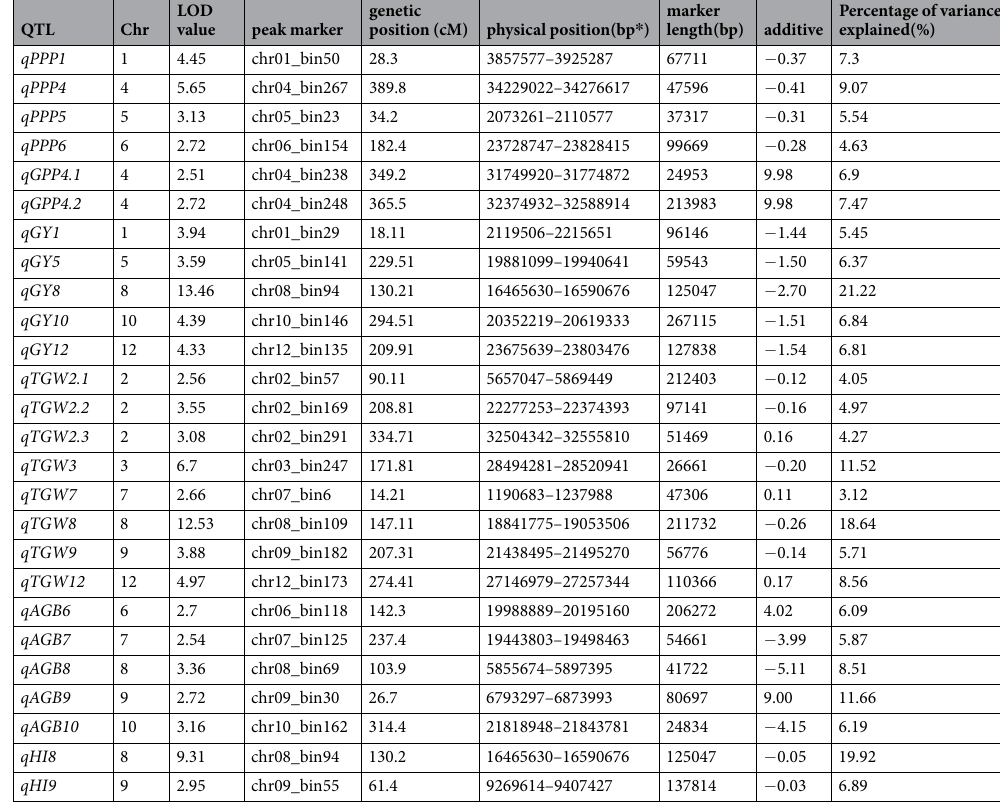
Table 4. QTLs for yield components identified in the R998 × Francis RILs population. Note:“ * ” denote physical positions based on the MSU Rice Genome Annotation Project release 7 (http://rice.plantbiology.msu. edu/). PPP, panicles per plant; GPP, grains per panicle; GY, grain yield per plant; TGW, thousand grain weight; AGB, above-ground biomass; HI, harvest